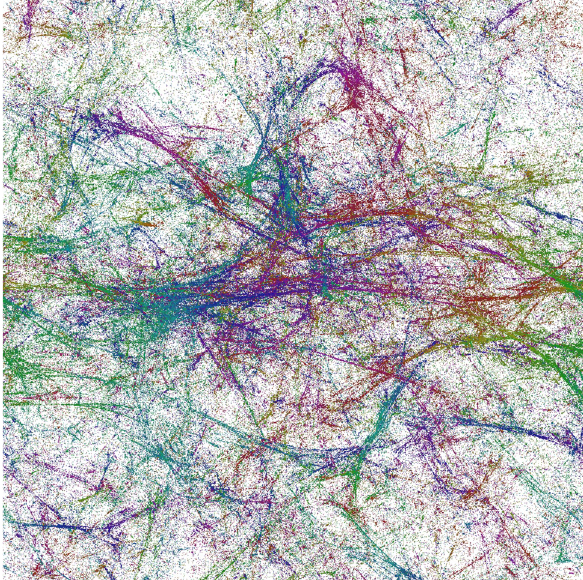
Fig. 2 The projection of four-volume on the tx -plane for a CDT con- figuration. There is a strong correlation between the original t -foliation (color) and new time coordinate ψ t (horizontal